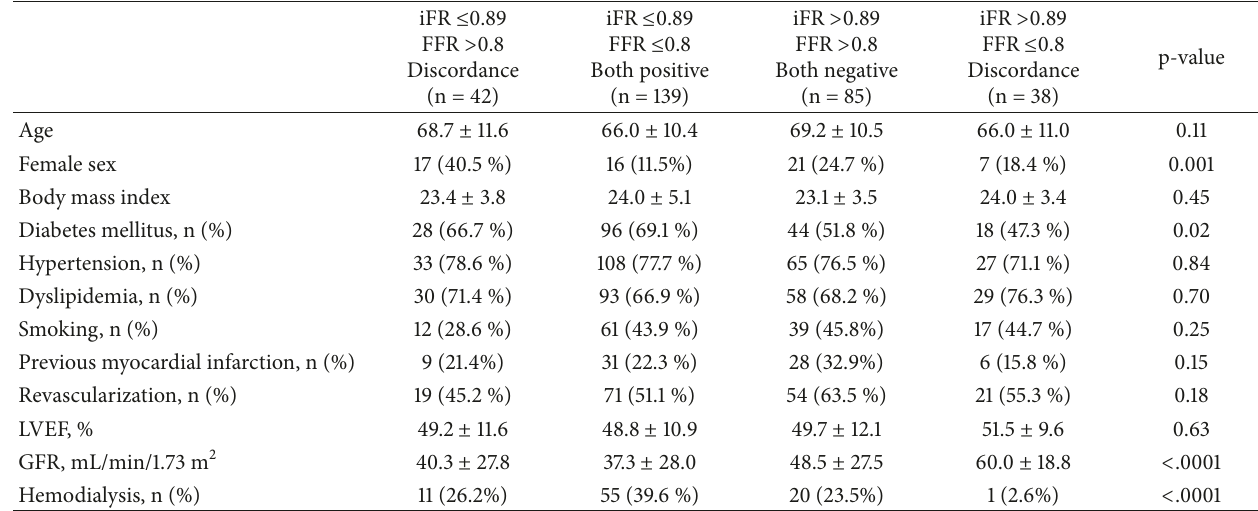
Table 2: Lesion characteristics of the concordant and discordant groups.